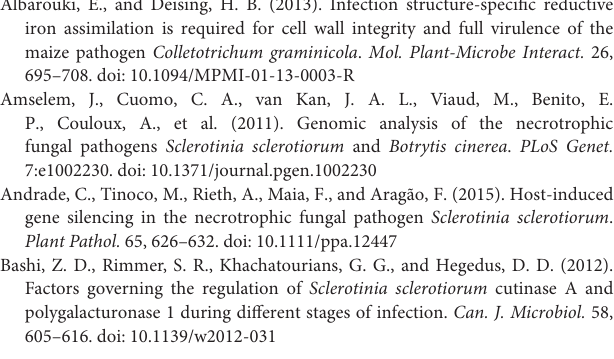
Supplementary Figure 1 | Expression of MAS-related genes in S. sclerotiorum during infection. Expression of five MAS-related genes in S. sclerotiorum during the inoculation of Brassica oleracea leaves (A) and stems (B) , as revealed by RNA-seq in our previous study (Mei et al., 2016; Ding et al., 2019). (C) Top 10 expressed S. sclerotiorum genes during the inoculation of B. oleracea leaves. RL, resistant B. oleracea leaf; SL, susceptible B. oleracea leaf; RS, resistant B. oleracea stem; SL, susceptible B. oleracea stem; 0h, pre-inoculation; 6h, 6h post-inoculation; 12h, 12h post-inoculation; 24h, 24h post-inoculation. Supplementary Figure 2 | Expression analysis of Sscnd1 and its homologous genes during the inoculation of rapeseed leaves. The quantity of Sstub1 was used to normalize the expression levels of every gene in different samples. The relative expression of SS1G_11468 at 0h was set as one. Mean values from three independent assays were used to construct the heatmap. Supplementary Figure 3 | Expression analysis of the Sscnd1 homologous genes in Sscnd1 gene-silenced strains. (A) Multiple alignment of the amplified 418 bp of Sscnd1 with the other four homologous genes in S. sclerotiorum . (B) Relative transcript levels of the four homologous genes in the Sscnd1 gene-silenced strains. The quantity of Sstub1 was used to normalize the expression levels of Sscnd1 in different samples. Error bars indicate the standard deviation of three independent assays. Differences in every gene group were assessed using Tukey’s HSD test, respectively. Different letters indicate statistical significance at the 0.05 level ( P < 0.05). Supplementary Figure 4 | The correlation between the Sscnd1 expression and the compound appressorium numbers. Sicnd1-9, Sicnd1-10, Sicnd1-15, Sicnd1-16, Sicnd1-17, and Sicnd1-20 were six Sscnd1 gene-silenced strains. Supplementary Figure 5 | Expression changes of Sscnd1 and its homologous genes in Sicnd1-9 and Sicnd1-20, as revealed by RNA-seq. FC: Fold change (Sicnd1-9 or Sicnd1-20 vs. wild-type strain). Supplementary Figure 6 | Expression changes as estimated by RNA-Seq (black bars) and qRT-PCR (gray bars) for 15 S. sclerotiorum genes of interest. Supplementary Figure 7 | Functional assessment of Sscnd1 in S. sclerotiorum pathogenicity determined by TRV-mediated HIGS. (A) Disease phenotypes of Mock (mock-inoculated with FES buffer)-, TRV::GFP-, TRV:: Sscnd1 -1- and TRV:: Sscnd1 -2-inoculated N. benthamiana leaves at 48 hpi with S. sclerotiorum strain 1980. (B) Quantification of the lesion area in (A) . Error bars indicate the standard deviation for five replicates. Differences were assessed using Tukey’s HSD test. Different letters indicate statistical significance at the 0.05 level ( P < 0.05). (C) Relative transcript levels of Sscnd1 in the Mock-, TRV::GFP-,